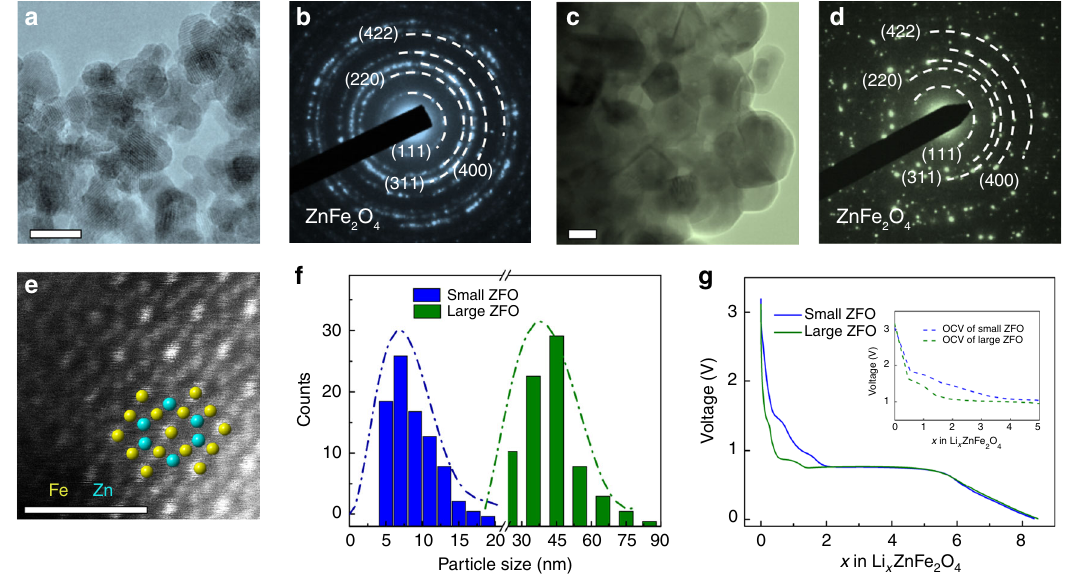
Fig. 1 Characterization of pristine materials and electrochemical properties. a Typical morphology of S-ZFO (scale bar: 10 nm) and b the corresponding SAED pattern. c Typical morphology of L-ZFO (scale bar: 10 nm) and d the corresponding SAED pattern. e HAADF-STEM image showing the spinel structure along the <101> zone axis, compared to an overlaid atomic model along the same projection. Scale bar: 1 nm. f Size distribution of S-ZFO (blue) and L-ZFO (green). g Discharge pro fi le of S-ZFO (blue) and L-ZFO (green) measured at the rate of 200 mAg − 1 . Inset shows the OCV pro fi le of S-ZFO and L-ZFO, respectively